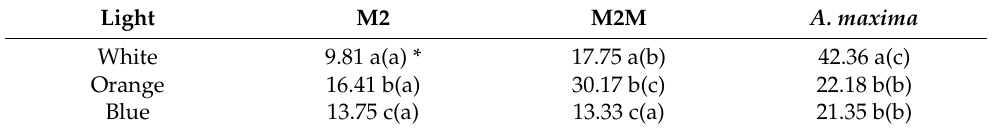
Table 3. Carbohydrate amounts (g 100 g − 1 ± RSD DW) under the different experimental conditions of the three